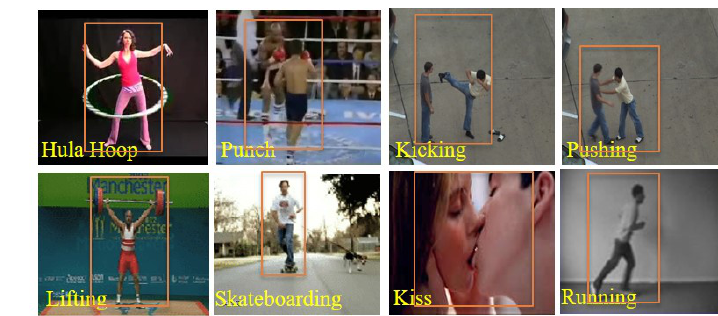
Figure 18. Some sample results of action